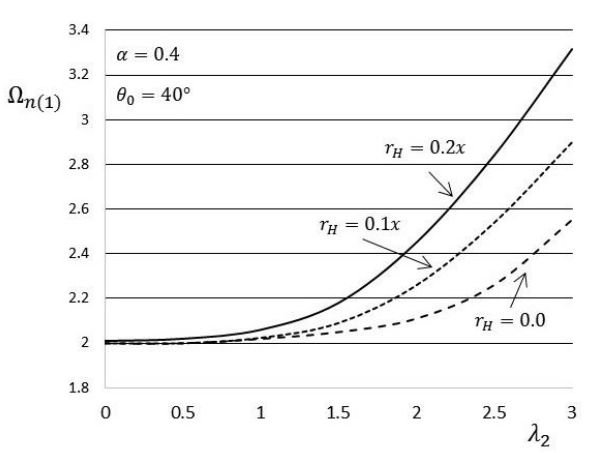
Figure 8. E ff ect of the hub radius parameter on the first frequency. Figure 8. Effect of the hub radius parameter on the first frequency.